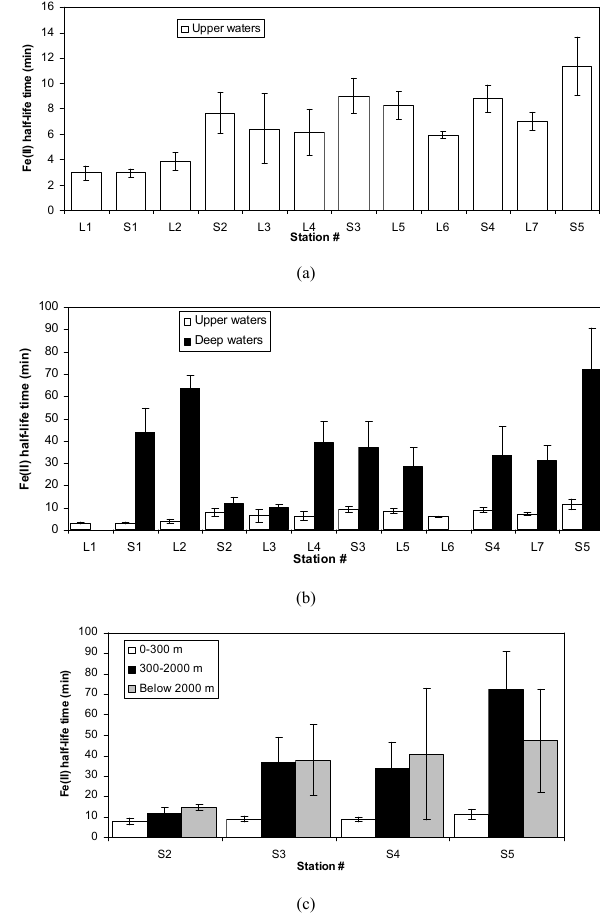
◦ C in minutes for (a) sur- Figure 5 Fig. 5. Measured Fe(II) half-lifes at 4 face waters (20–300m), (b) both surface and deep waters (300– 2000m), and (c) surface, 300–2000m deep and 2300–3600m deep waters. The bars represent the mean value calculated from the four Fe spikes and the error bars the standard